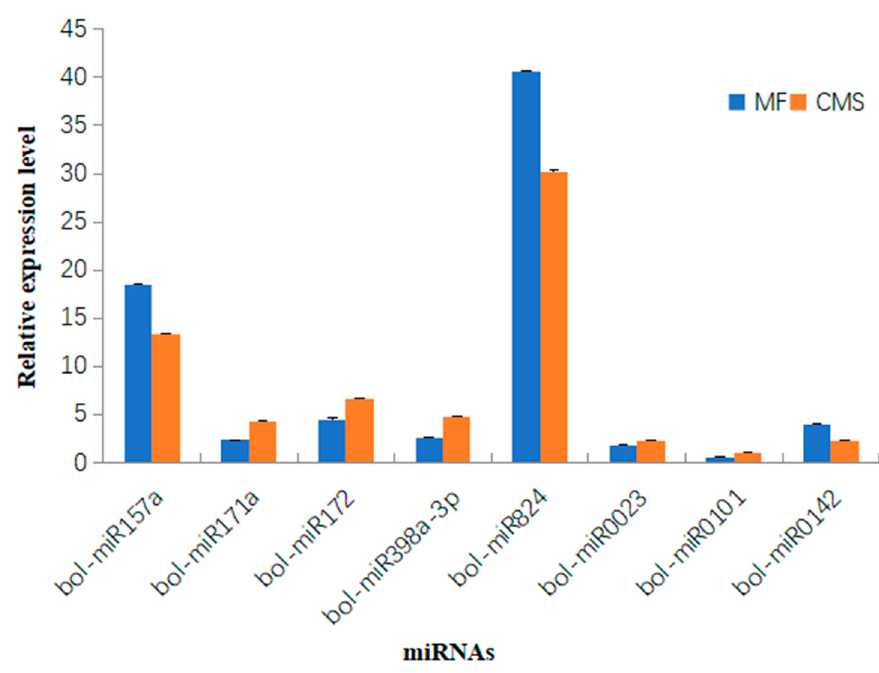
Figure 5. Expression analysis of 8 miRNAs in MF and CMS of cabbage by